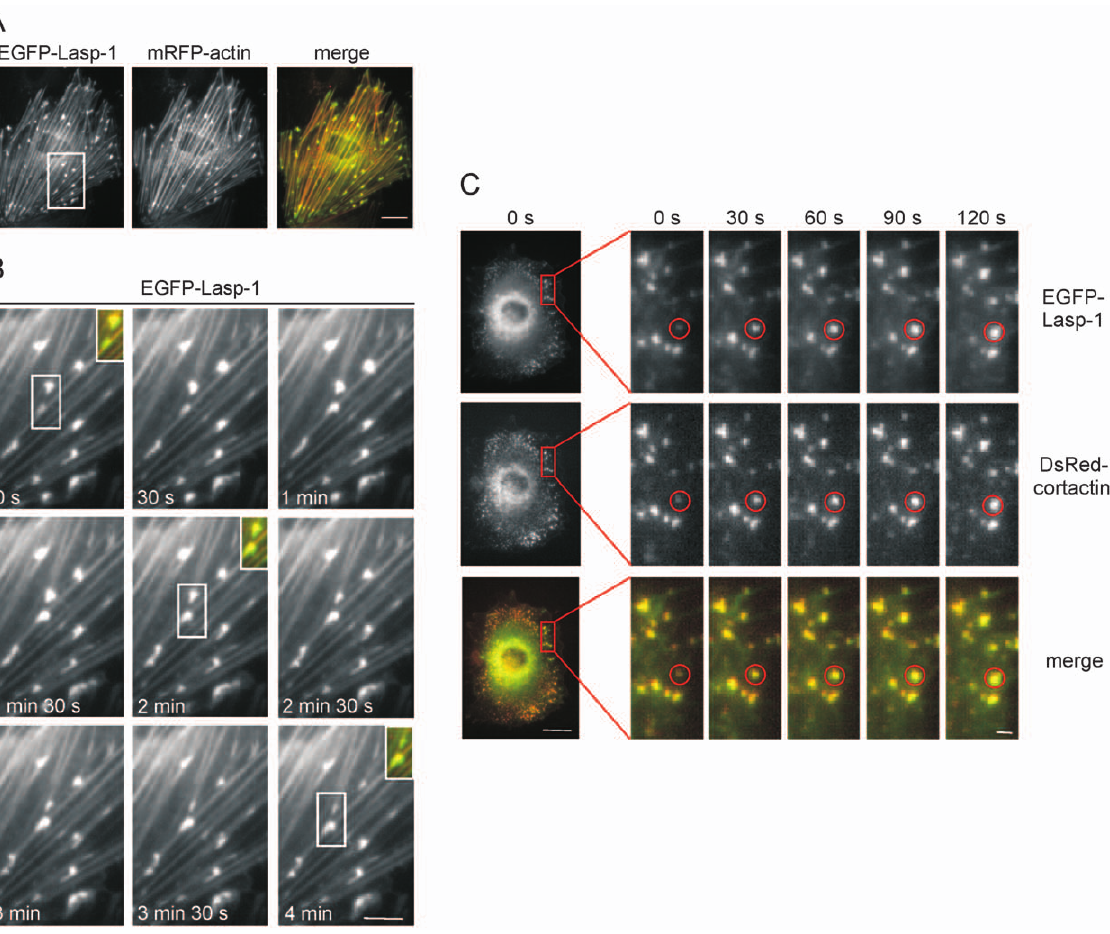
Figure 3. Lasp-1 recruitment is associated with early stages of podosome biogenesis. ( A ) Colocalization of recombinant EGFP-Lasp-1 and recombinant mRFP-actin at podosomes in PDBu-treated A7r5 cells. The white box marks the enlargement shown in Fig. 3B. Bar represents 25 m m. ( B ) Appearance of EGFP-Lasp-1 during assembly and disassembly of podosomes (white boxes) in PDBu-treated cells over a period of 4 min. Inserts in the pictures taken at 0 s, 2 min. and 4 min. show the merged EGFP-Lasp-1 (green) and mRFP-actin (red) signals in two individual podosomes. Bar represents 2 m m. ( C ) Colocalization of EGFP-Lasp-1 (upper row) and DsRed-cortactin (middle row, merged pictures in the lower row) during initial stages of podosome assembly in PDBu-treated A7r5 cells over a period of 2 min. An individual podosome is marked by a red circle. Bars represent 25 m m (left panel) or 2 m m (right panels), respectively.